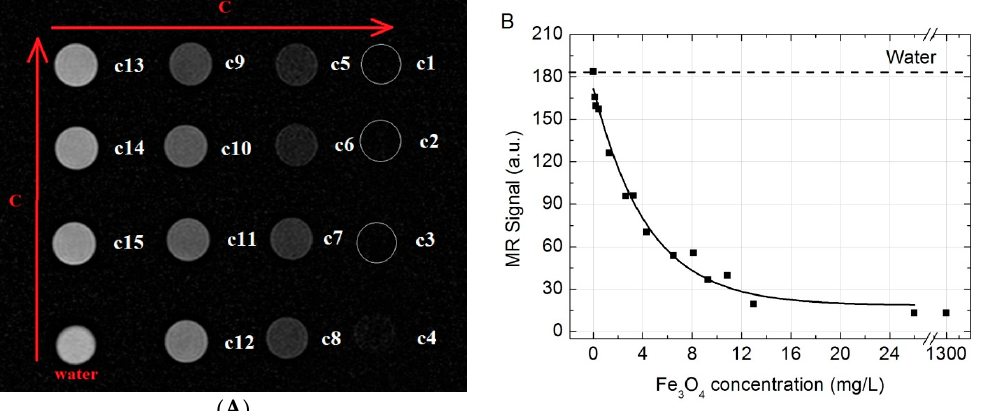
Figure 4. ( A ) T2W MR coronal slice images in vitro of different concentrations of Fe 3 O 4 dissolved in water (from c1 (1300 mg/L) to c15 (13 mg/L)); ( B ) T2W MR signal intensity plot of aqueous suspensions of Fe 3 O 4 versus the concentration in the solution. Dotted line marks water MR signal.